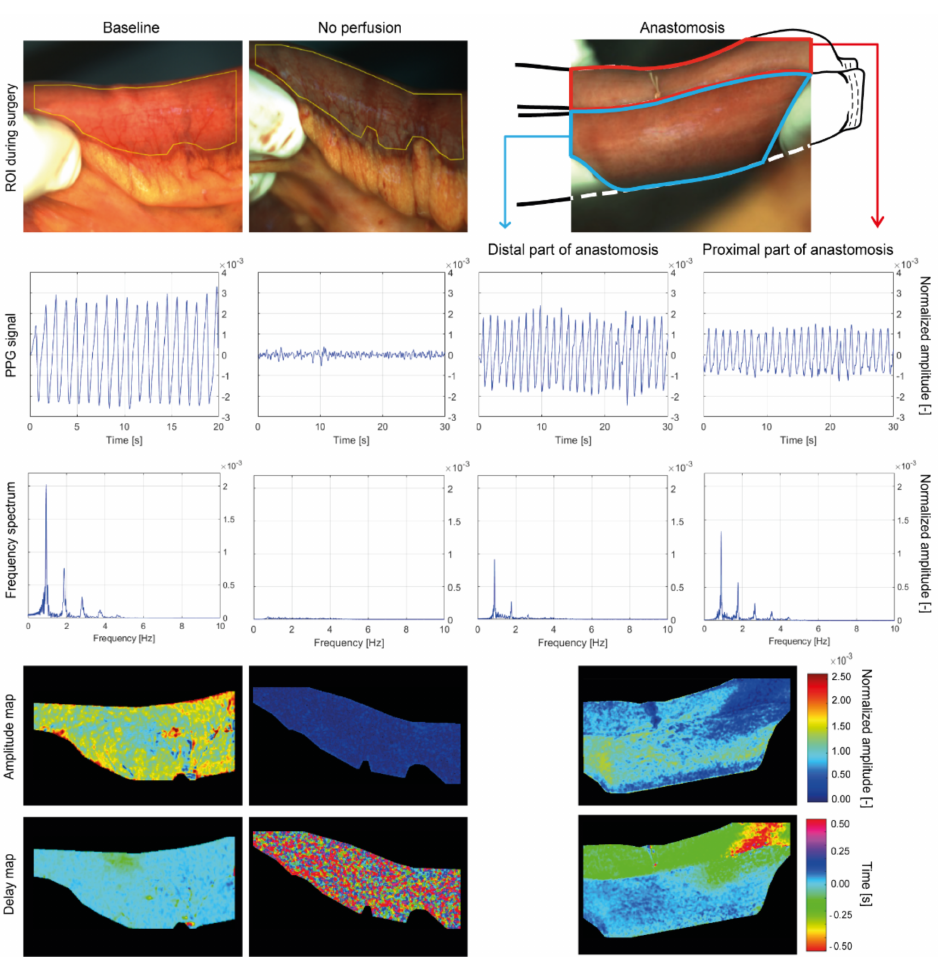
Figure 4. Analysis of the PPG signals and maps of the videos collected during intestinal surgery. The columns indicate the stages of surgery at which the videos were collected, namely baseline , no perfusion , and anastomosis . For the baseline stage, only 20 s of videos were recorded, instead of 30 s. The top row shows the RGB images of the intestine acquired during surgery, with the yellow contour indicating the ROI selected for processing. The ends of the intestines are stapled after removing the tumor and the continuity of the intestines was restored using a side-to-side anastomosis (schematic extension baseline , anastomosis ). Distal and proximal ends of the anastomosis are processed separately. The second row shows the global PPG signal extracted from the yellow ROI. The third row shows the frequency spectrum of the PPG signal. The global PPG signal and the frequency spectrum of the distal and proximal ends of the anastomosis are processed separately. The fourth row displays the PPG amplitude maps, normalized with respect to the maximum among all the stages. The fifth row shows the PPG delay maps, normalized between − 0.5 and 0.5